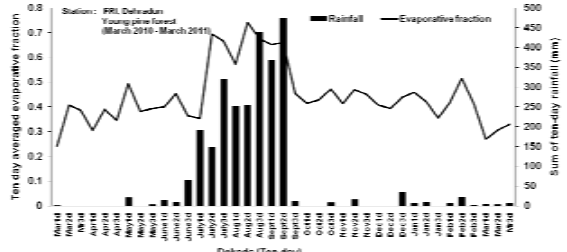
Figure 3. Seasonal variation of evaporative fraction The plot of day-time averaged evaporative fraction ( (cid:2) and sum of ten-day rainfall showed that evaporative fraction varied between 0.23 to 0.75 (Figure 3) throughout the pine growth